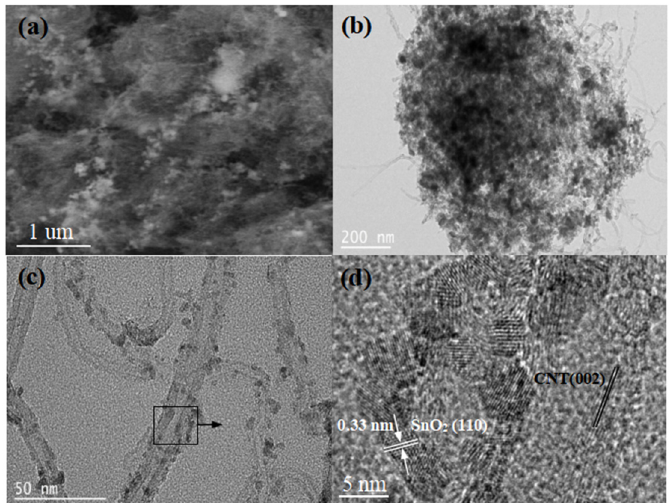
Figure 2. ( a ) SEM, ( b , c ) TEM and ( d ) HRTEM images of SnO 2 /CNT NNs composites. The XRD patterns of bare SnO 2 and SnO 2 /CNT NNs composites are shown in Figure 3a. The red line shows the main diffraction peaks of SnO 2 , by comparison with